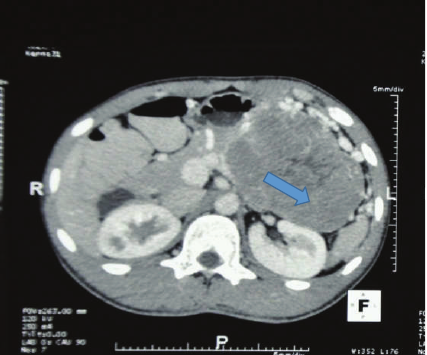
Figure 1: CT image demonstrating presence of a heterogeneous well-demarcated mass arising from the body and tail of the pancreas (marked with a blue arrow) and extending towards the splenic hilum.